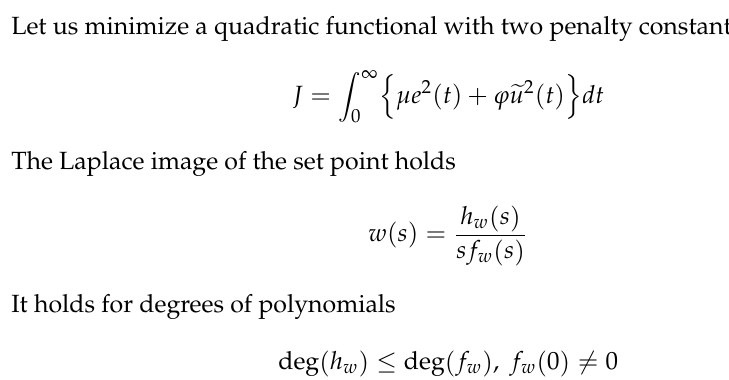
Figure 4. System with feedback